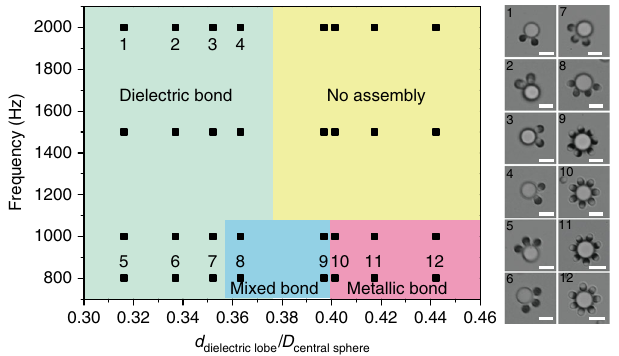
Fig. 5 Phase diagram of selective and directional colloidal bonds. Diagram showing regions of various bonding scenarios, constructed using patchy particles with identically sized metallic lobe but different dielectric lobes and assembled with 4- µ m central spheres at various AC frequencies. Scale bar: 4 μ